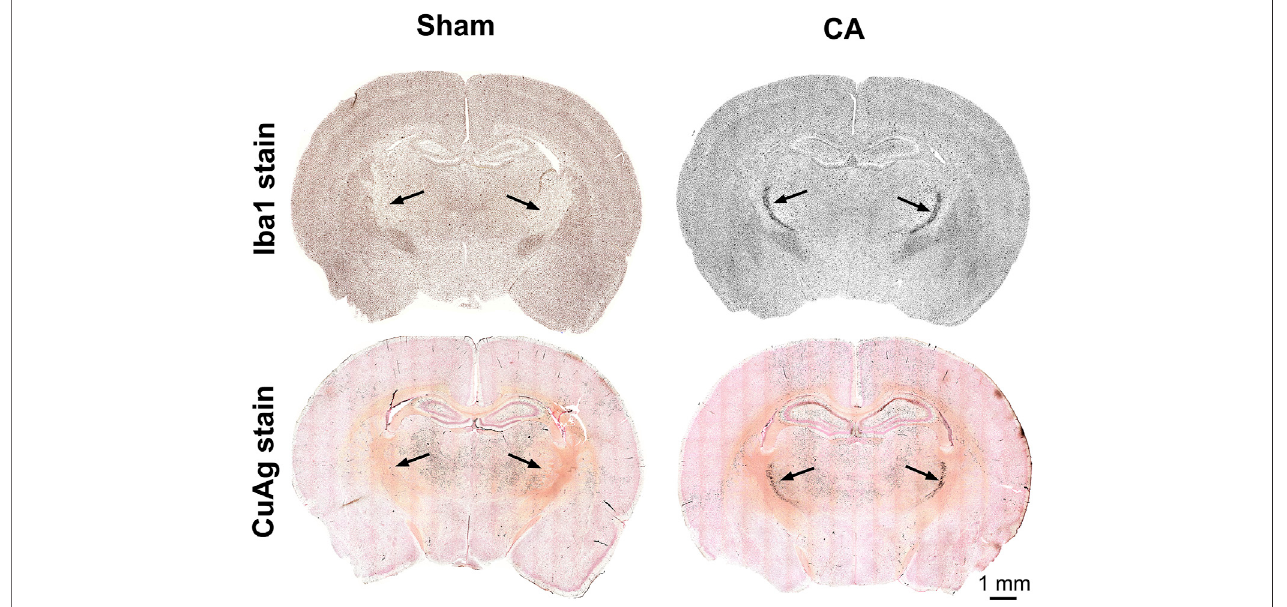
FIGURE 2 | Coronal sections of CuAg and Iba1 labeling from sham and CA rats. The whole brain immunohistochemistry labelling Iba-1 and Amino Cupric Silver (CuAg) show the profound neuronal degeneration and microglial activation, respectively, in the speci fi c region within the thalamus from 12.5 min CA compared to sham rats. The black arrows indicate the location of CA-induced injury in the thalamus,